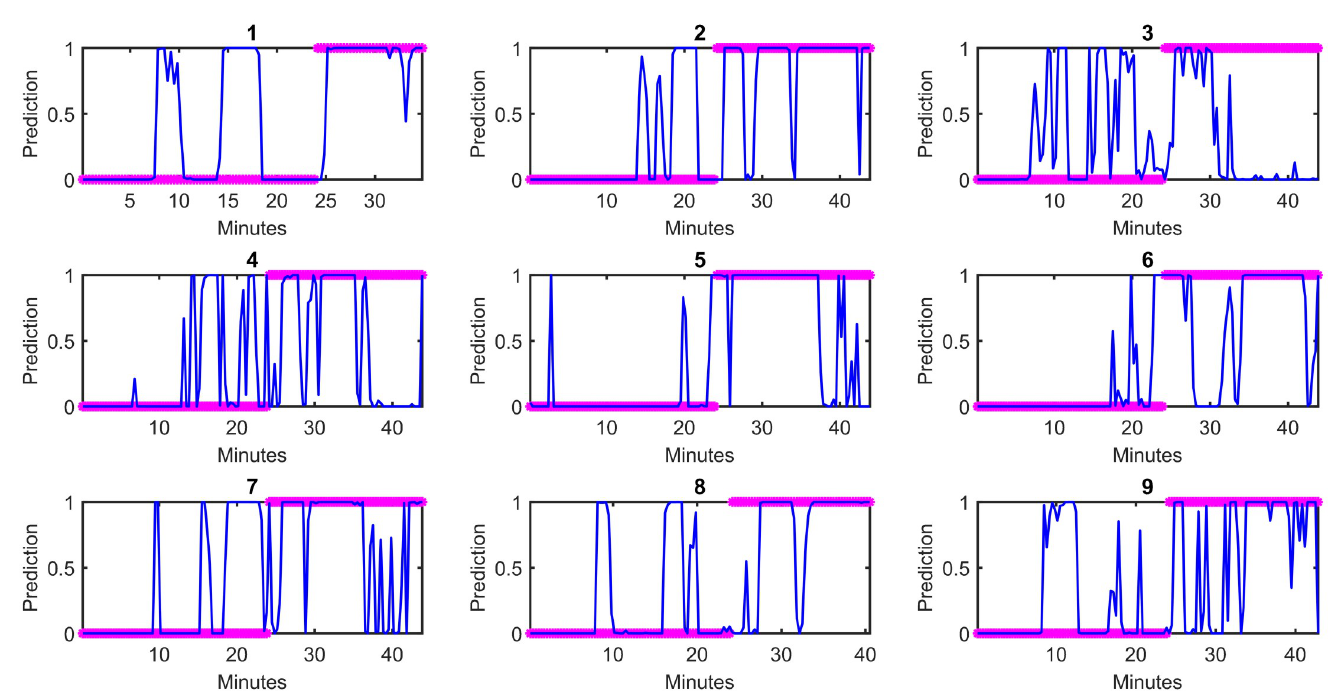
Fig 7. Autonomic predictions by subject from the best logistic regression model for Question 3. Unlike in Figs 5 and 6, with respect to the behavioral markers, unconsciousness is 0 and consciousness is 1.